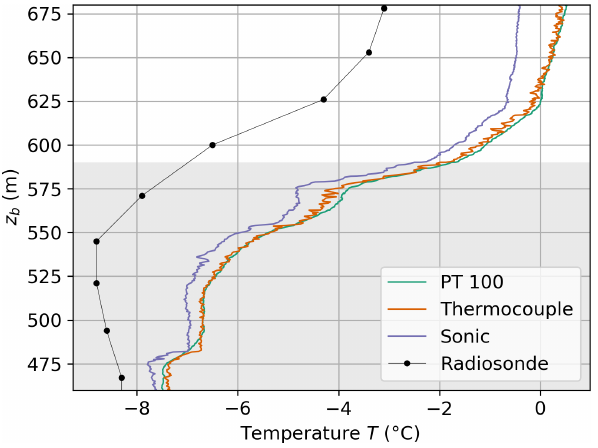
Figure 6. Comparison of balloon-borne temperature measurements measured with the UP descending at 10:00UTC on 7 June 2017. The plot shows temperature T as a function of barometric altitude z b around a temperature inversion capping the cloud layer (shaded area, determined from relative humidity and Cloudnet data). The temperature vertical profile includes the time-response-corrected PT100, corrected and calibrated thermocouple data, and tempera- ture calculated from the sonic temperature. Plotted data are aver- aged over 0.5s intervals. The temperature profile as observed from the radiosonde about 2h later is shown for